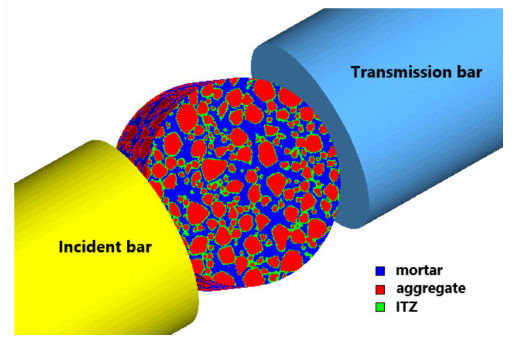
Figure 5. Three-dimensional mesoscale finite element